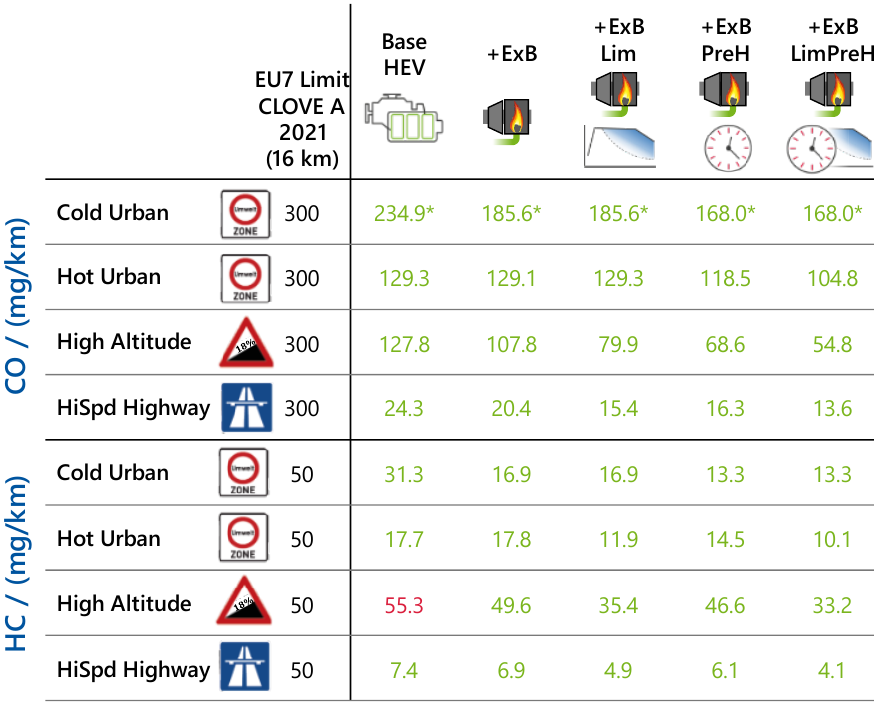
Figure A1. Electrical heater disk technology results for CO and HC in the Euro 7 scenarios.